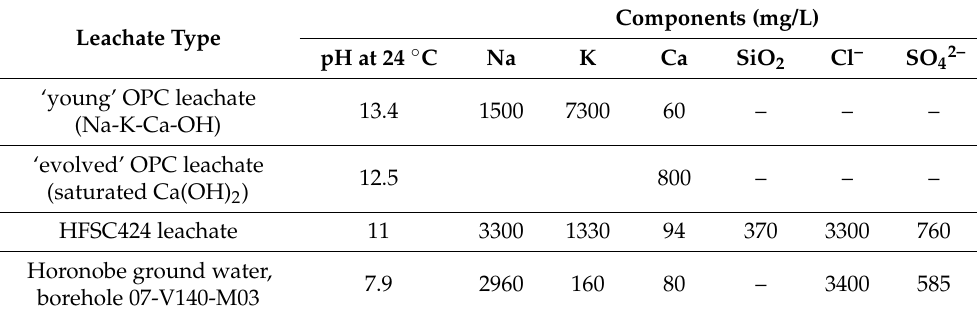
Table 1. Initial concentrations of ions in the fluids used for the